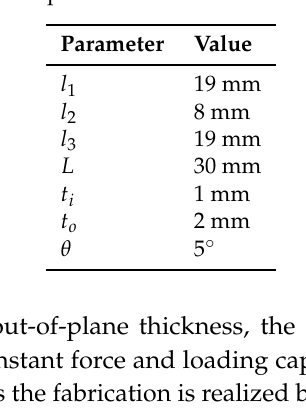
Table 2. Main parameters of the CCFM mechanism.